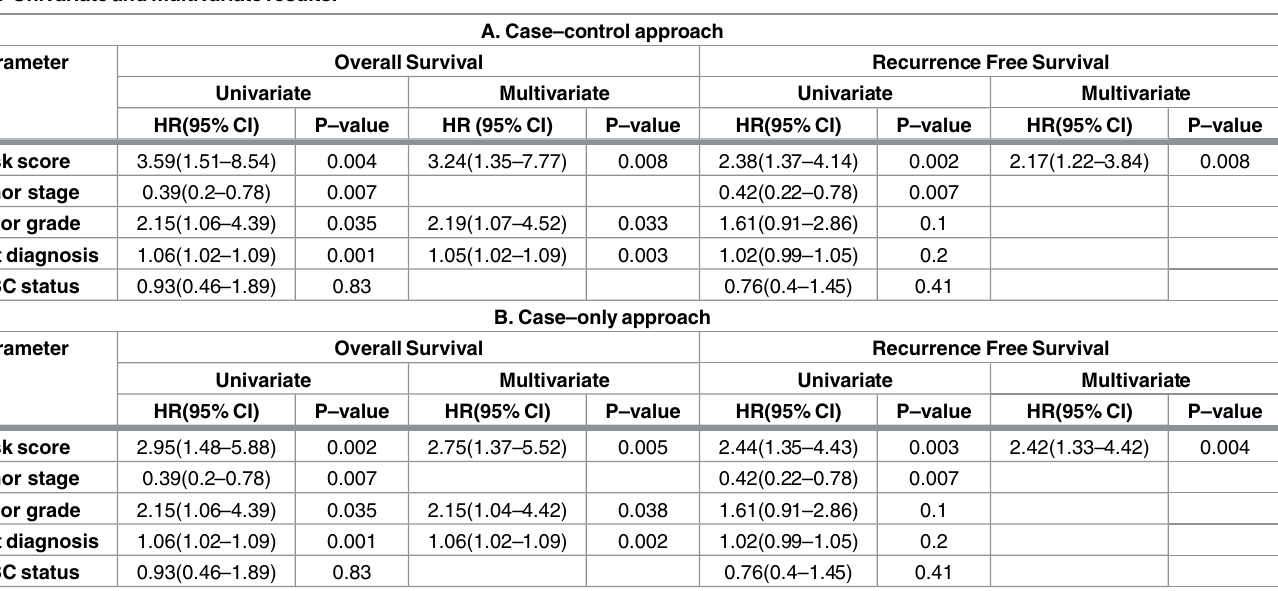
Table 1. Univariateand